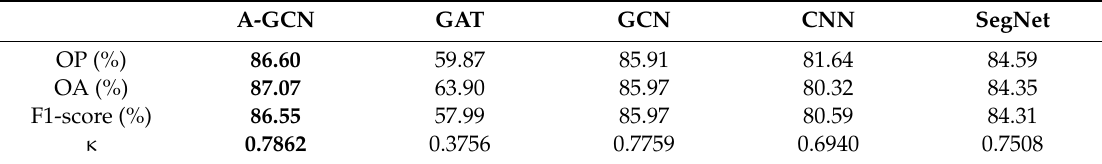
Table 5. Comparison of the overall segmentation performance with four state-of-the-art methods.